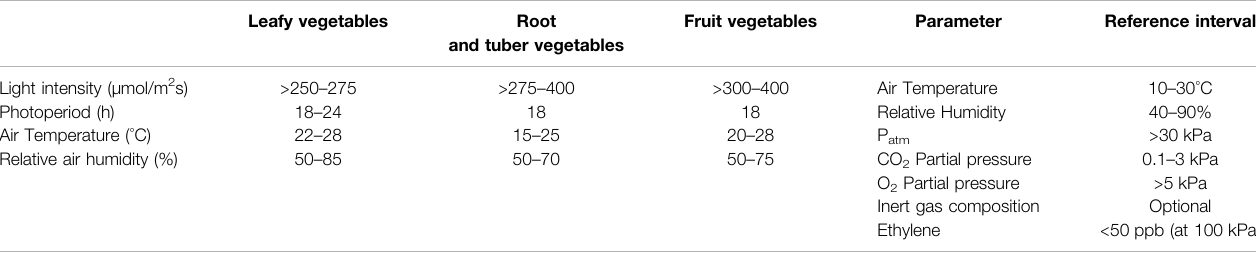
TABLE 1 | Plant growth requirements in terms of environmental parameters for the different crop types (left panel), and Reference intervals for environmental parameters for plant cultivation in controlled environment at the NASA ’ s Biomass Production Chamber (right panel) (Wheeler et al., 1996a). Leafy vegetables Root Fruit and tuber vegetables